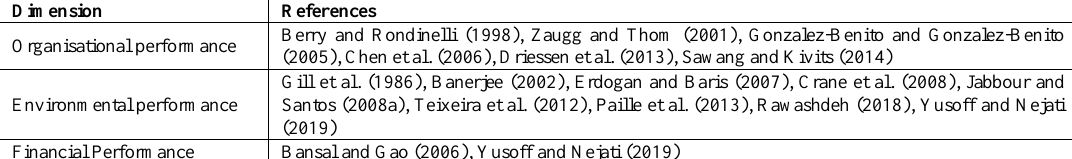
Table 6. Benefits of adopting